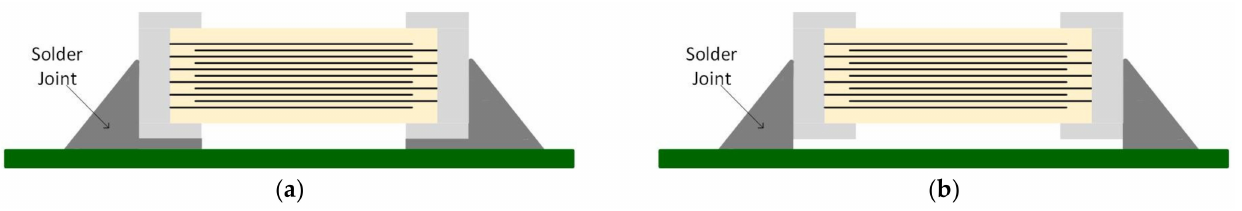
Figure 13. MLCC soldering ( a ) Classical soldering; ( b ) Proposed